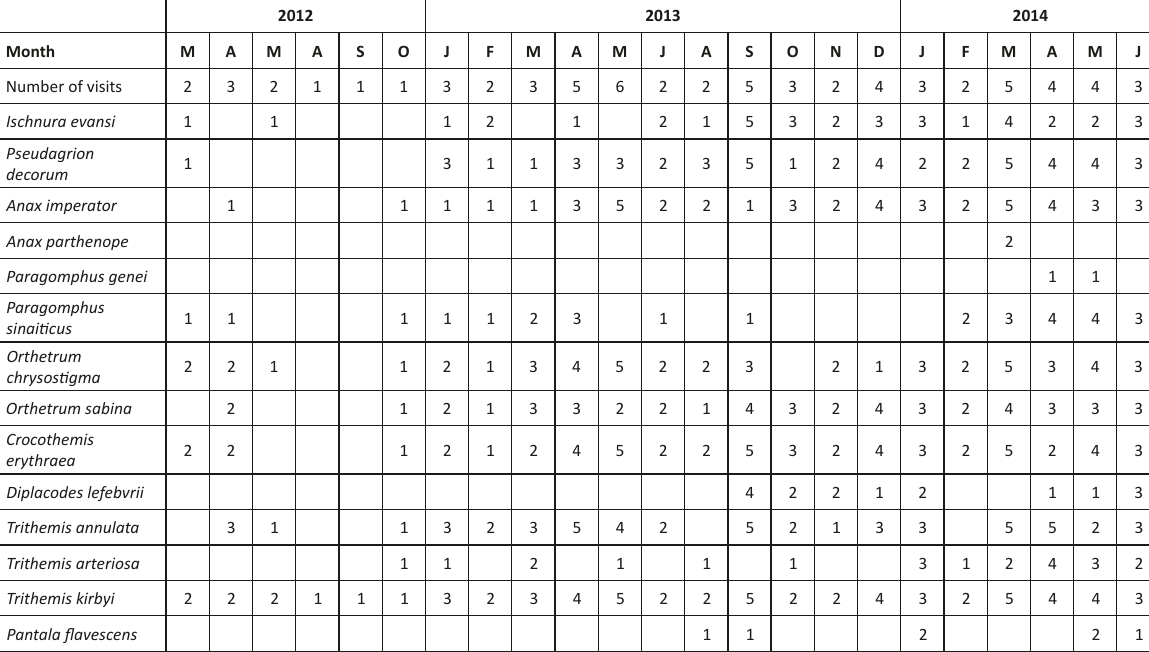
Table 2. Monthly occurrence of odonate species at the wadi pool, March 2012 to June 2014. No visit was made June, July, November, December 2012 and July 2013. The number of visits in a month, and the number of visits of a month when a species was recorded